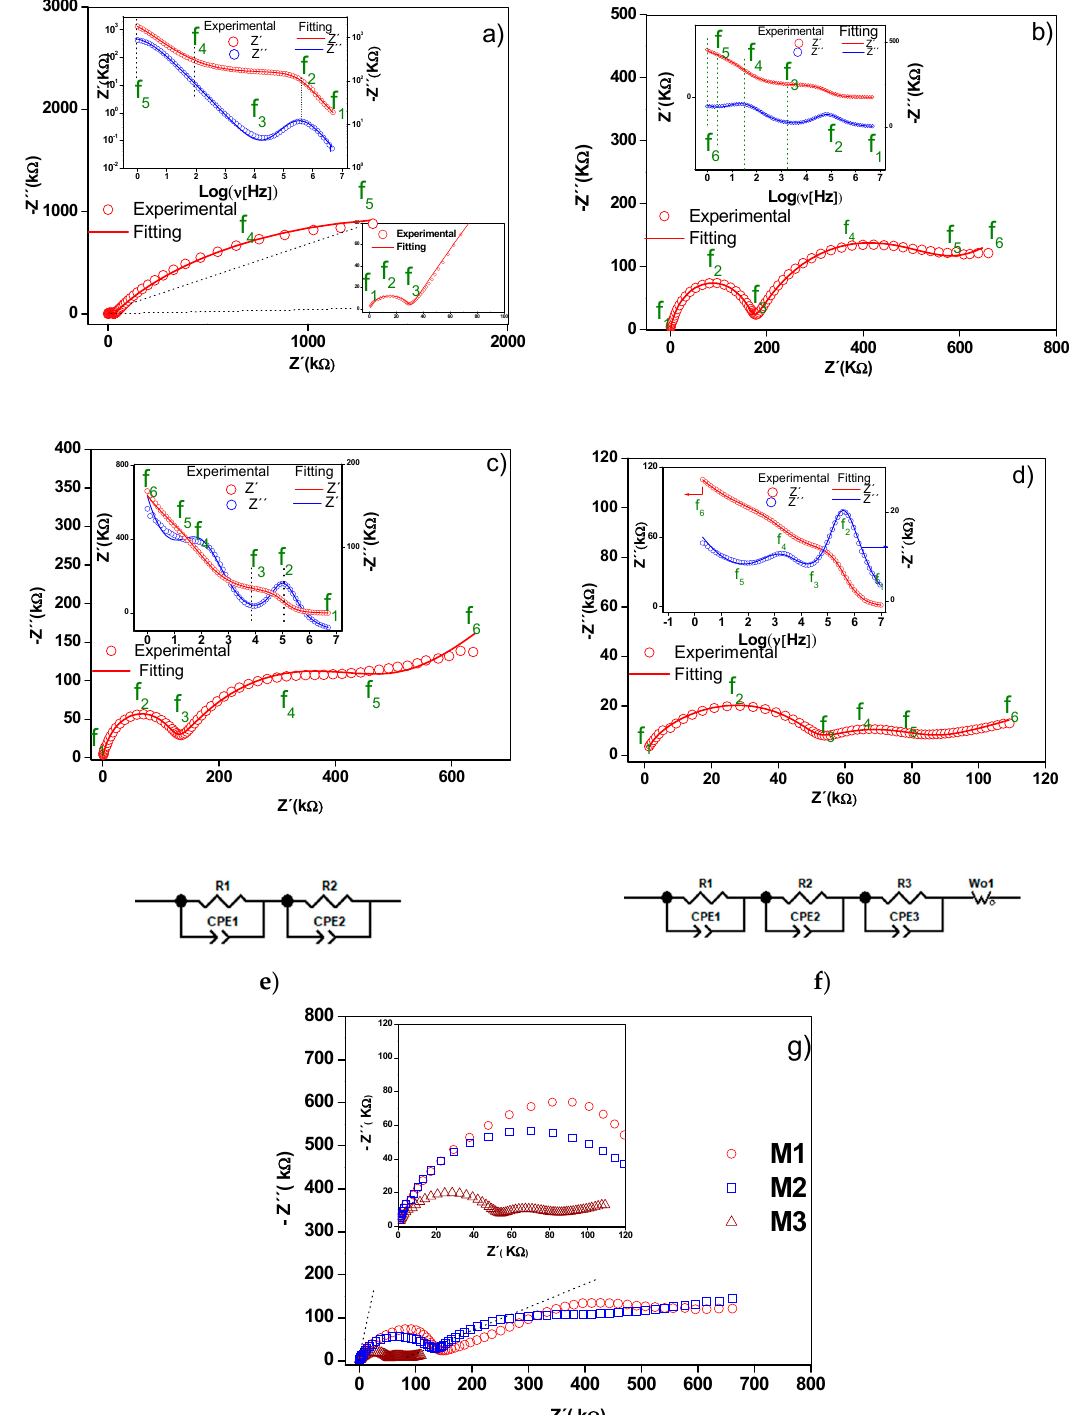
Figure 5. Nyquist diagrams for ( a ) alumina, ( b ) M1, ( c ) M2 and ( d ) M3. Equivalent circuits ( e , f ) that have physical meaning and are adjusted to the experimental data. Comparative Nyquist diagram for ( g ) supported birnessite. The Bode diagrams are inserted in the respective Nyquist diagrams.